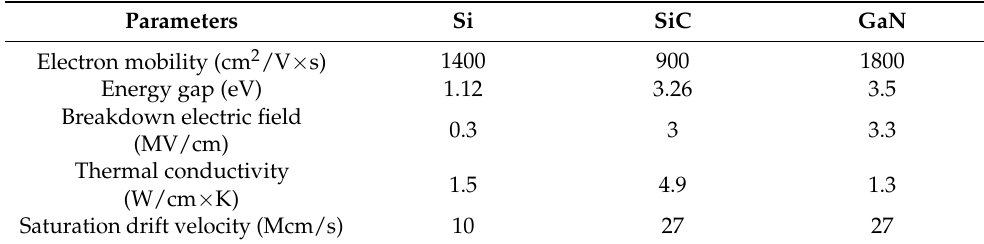
Table 14. Parameter Comparison of Si, SiC, and GaN